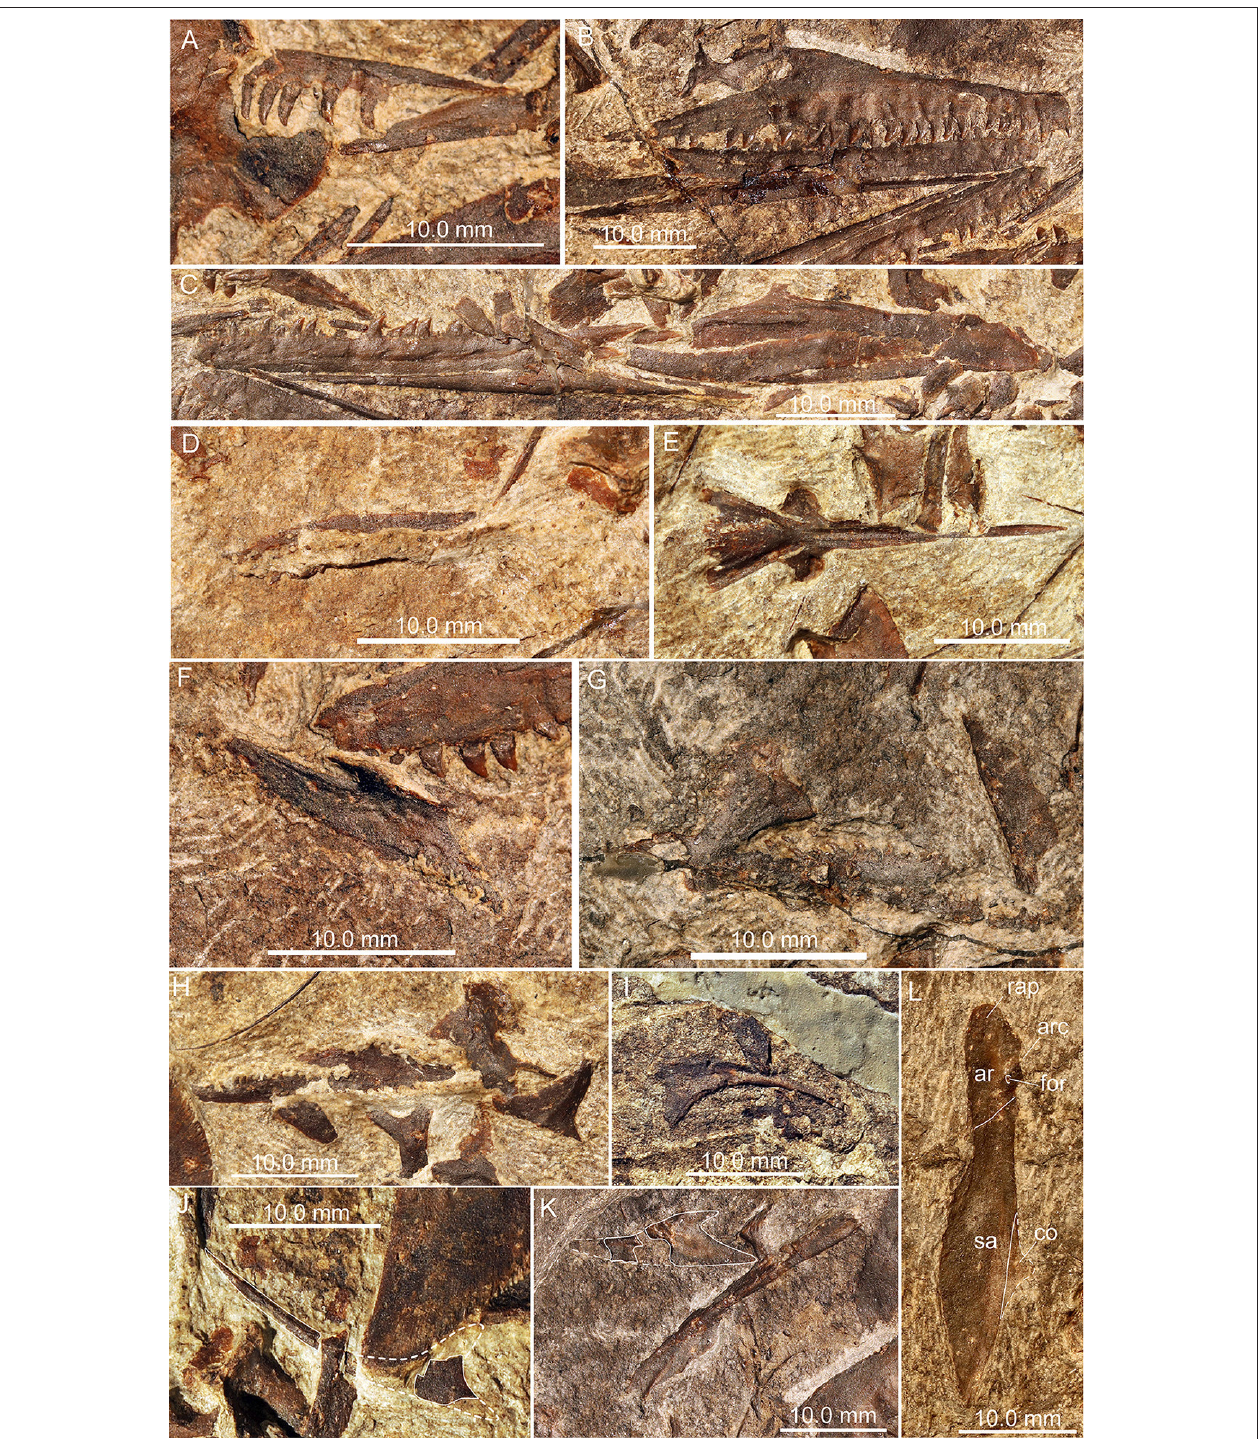
FIGURE 3 | Photographs of selected skull elements of PIMUZ T 1559. (A) Left premaxilla in lateral view; (B) right premaxilla, maxilla, and dentary in lateral view; (C) complete left lower mandible in lateral view; (D) vomer in ventral view; (E) basisphenoid in ventral view; (F) palatine in ventral view; (G,H) pterygoids in ventral view; (I) right jugal in lateral view; (J) left jugal in lateral view with white outline indicated; (K) nasal and possible left ectopterygoid with white outline indicated; (L) posterior portion of right lower mandible in lateral view.